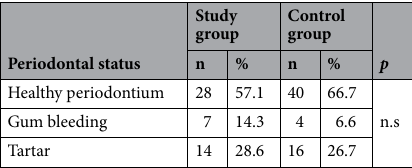
Periodontal status